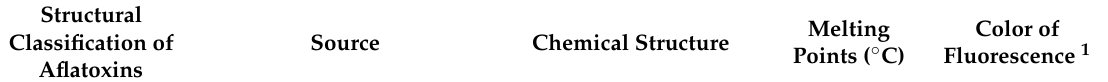
Table 1. Summary of structure and biochemical characterizations of